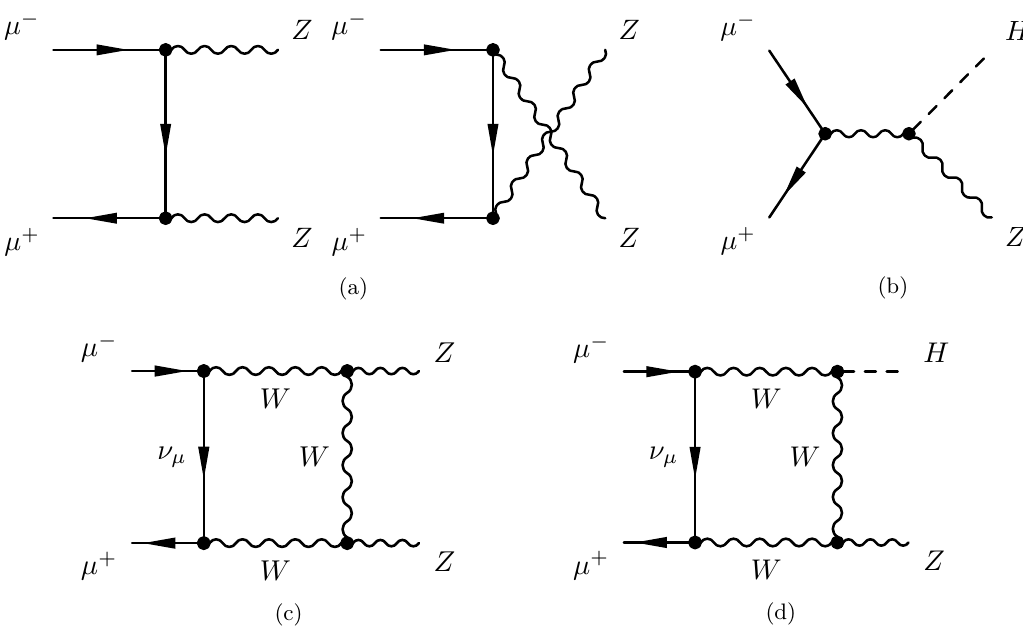
Figure 1 . Upper row: tree-level diagrams for the processes µ + µ − → ZZ in (a) and to µ + µ − → HZ (omitting tiny contributions from the muon Yukawa coupling here for simplicity) in (b), respectively. Lower row: representative one-loop diagrams for the virtual contribution to µ + µ − → ZZ in (c) and to µ + µ − → HZ in (d),